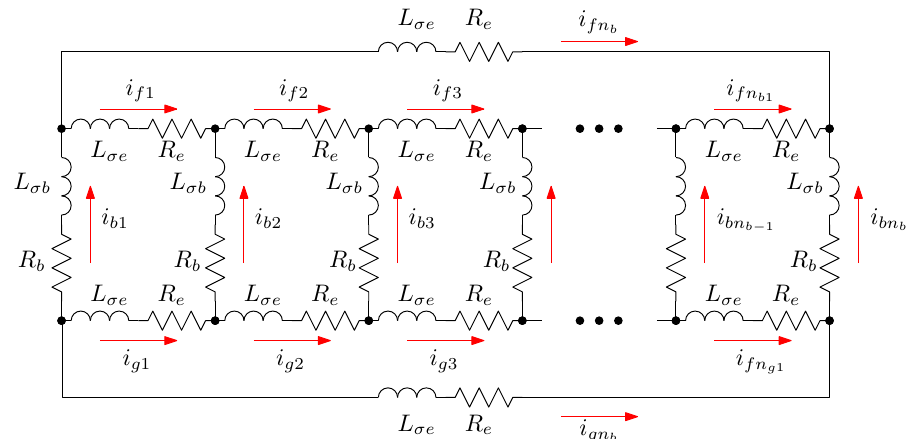
Figure 3. Primitive reference frame used for the rotor cage, with n b bars. Each bar and each end ring segment have a rigidly attached coordinate axis. The bar and end ring segment currents are the components of the current tensor in this frame. The bars are coupled to each other and to the stator currents through their mutual inductances (not shown in this circuit). On the contrary, the end ring segments do not couple with the other windings through mutual inductances.